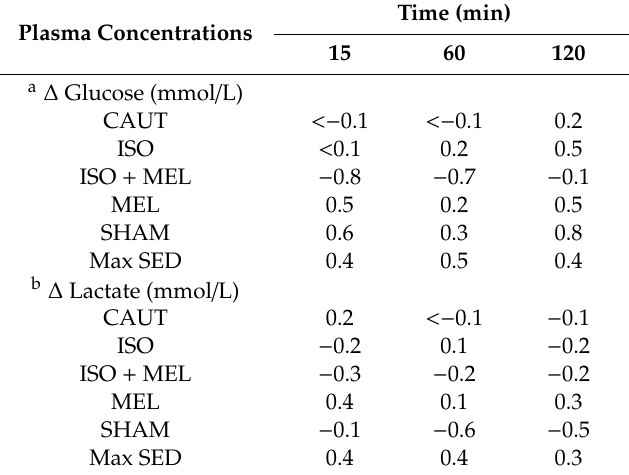
Table 2. Mean change ( ± maximum standard error of the di ff erence; SED) in plasma glucose and lactate concentrations (from baseline; mmol / L) over 2 h post-treatment of goat kids (n = 10 / treatment) that were either (i) cautery-disbudded with no pain relief (CAUT), or disbudded following administration of (ii) isoflurane (ISO), (iii) meloxicam s.c. and isoflurane (ISO + MEL) or (iv) meloxicam s.c.